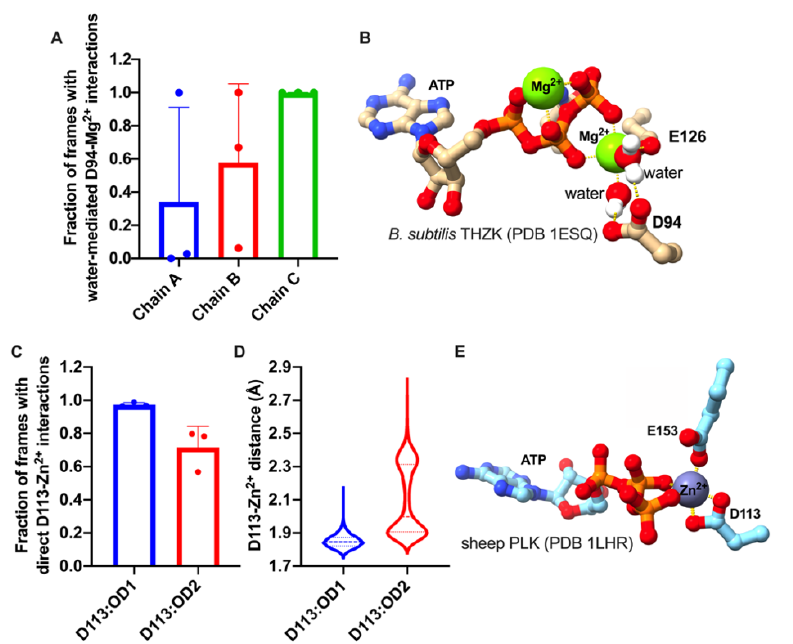
Figure 2. Role of the DPV motif in coordination of divalent metals. ( A ) Counting of water-mediated interactions between D94 and Mg 2+ from the MgATP complex in B. subtilis THZK. Dots represent the fraction of frames for each MD simulation. ( B ) Stick representation of the interactions between D94 from DPV and E126 from NXXE with MgATP. ( C ) Counting of direct interactions (<2 Å) between D113 and Zn 2+ from the ZnATP complex in sheep PLK. Dots represent the fraction of frames for each MD simulation. ( D ) Violin plot of the distance distribution between D113 and Zn 2+ . ( E ) Stick representation of the interactions between D113 from DPV and E153 from NXXE with ZnATP.